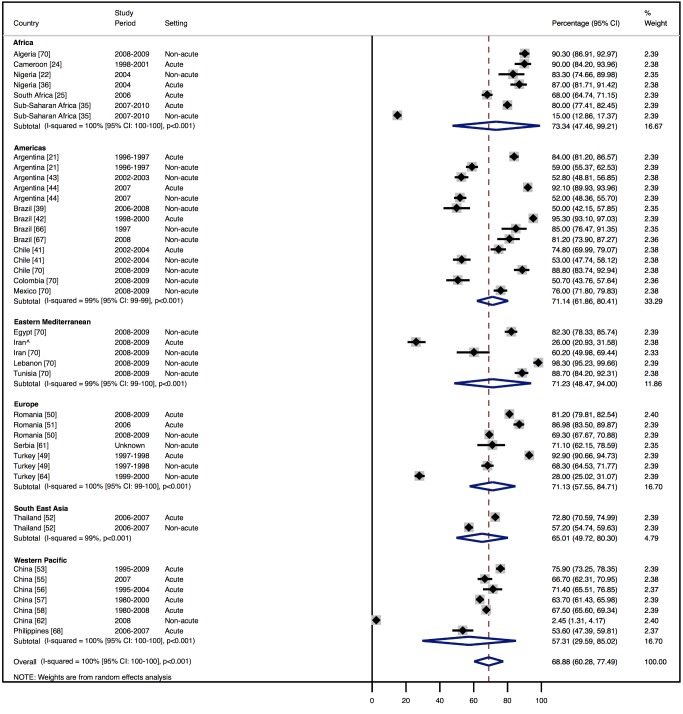
Diuretic use by region.Loop and/or thiazide diuretics. ∧Rahimzadeh S, Farzadfar F, Ghaziani M (2013) Iranian hospital data project (unpublished data).